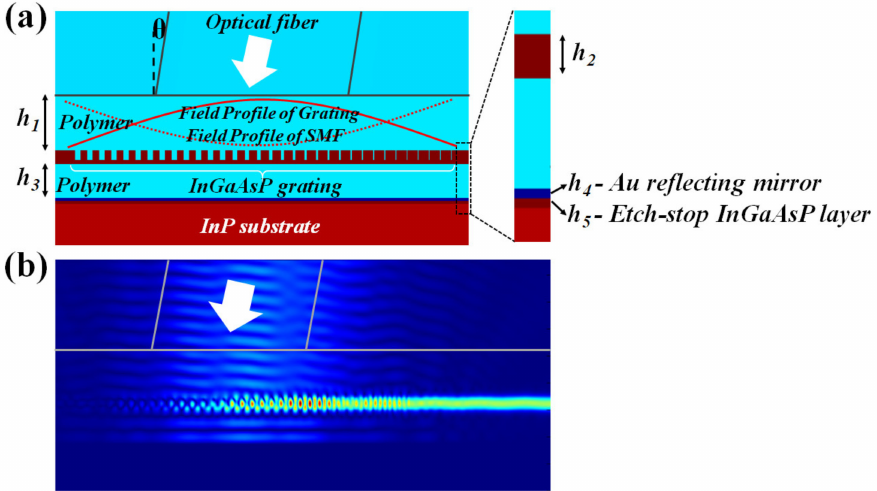
Figure 3. ( a ) The schematic and computational model for the vertical beam fiber-coupling apodized InGaAsP grating and ( b ) the optical field distribution between the optical fiber and grating, simulated by Lumerical 2D FDTD